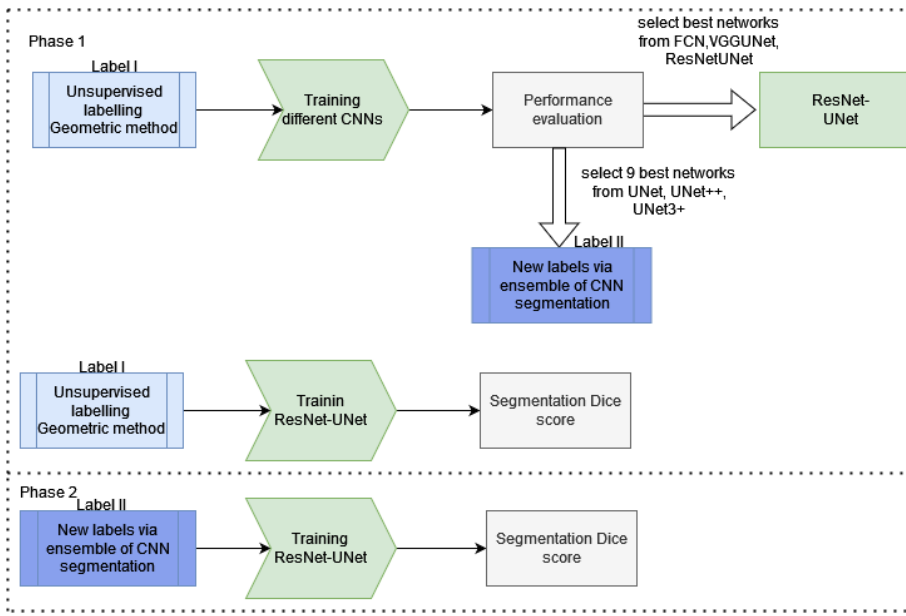
Figure 11. Pipeline for the